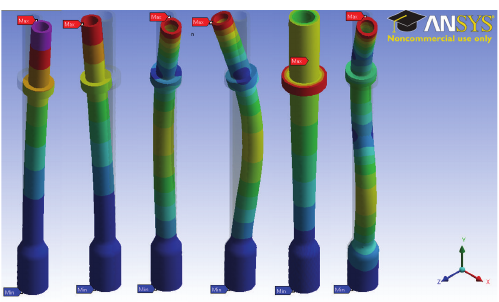
Figure 4: Mode shapes of the bare minaret model (Modes 1 to 6 are lined from left to right).